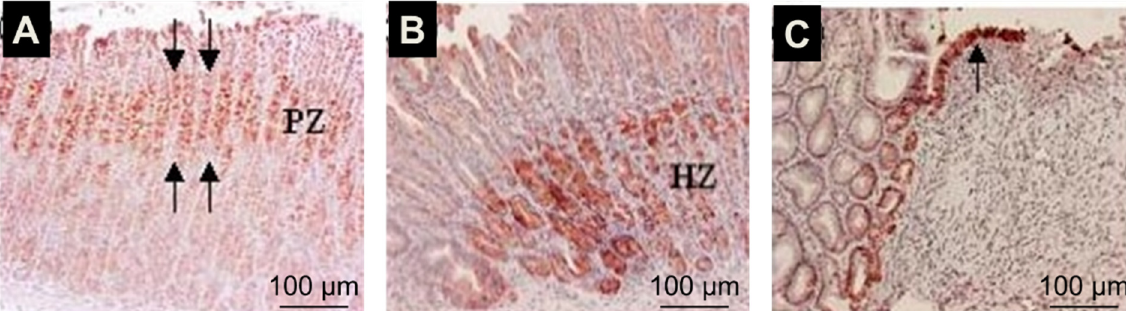
Figure 6. Gastric ulceration triggers local activation of IGF-1 in the ulcer margins. Immunostaining with an IGF-1-specific antibody and counterstaining with hematoxylin. In normal gastric mucosa, IGF-1 expression is localized to cells of the mucosal progenitor zone, PZ ( A ) (red staining). In ulcerated mucosa, IGF-1 expression is upregulated in the gastric ulcer margin healing zone, HZ, at day 6 ( B , C ). Epithelial cells migrating onto and re-epithelizing granulation tissue of gastric ulcers on day 6 also exhibited strong staining for IGF-1 (c, arrow). Control staining performed in the absence of primary antibody did not show any positive staining (reprinted with permission from [60]).